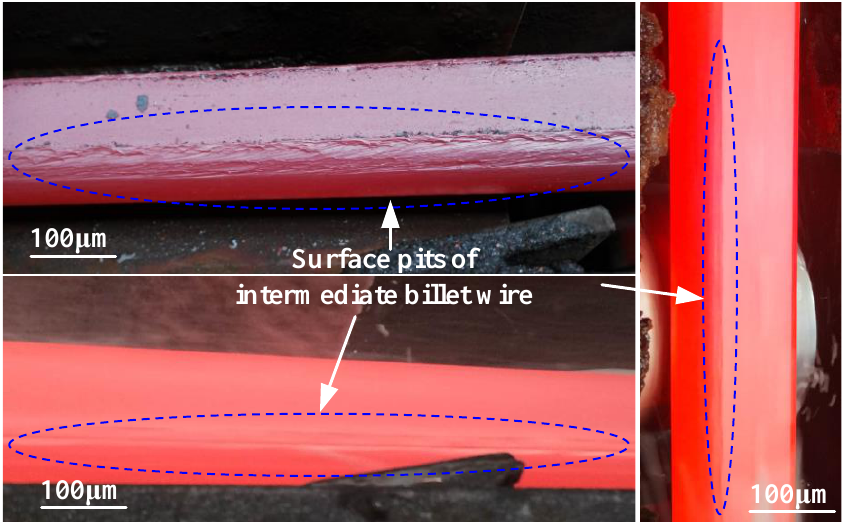
Figure 4. Schematic diagram of pits on the surface of the copper wire rod of the intermediate